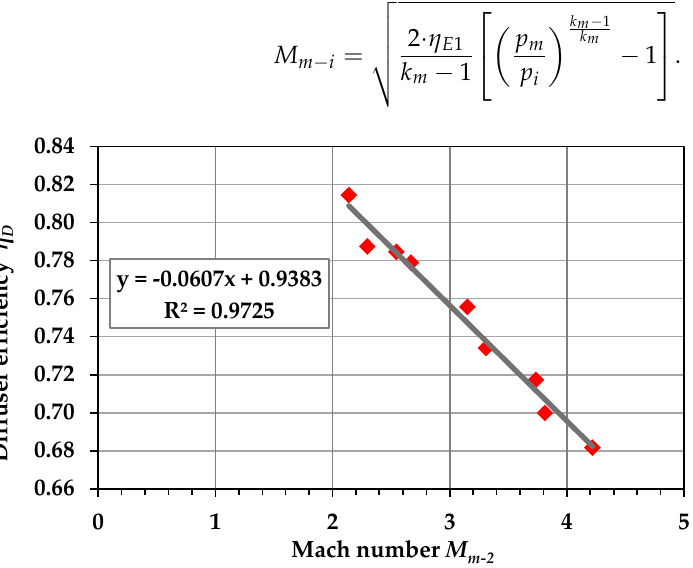
Figure 7. Experimental relationship between the diffuser efficiency η D and the Mach number M m − 2 of the motive gas at the final pressure p 2 .